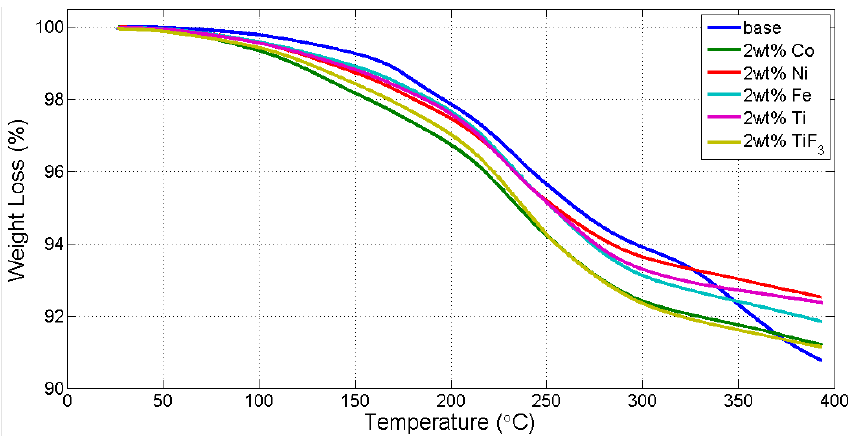
Figure 3. TGA analysis of the different catalysts on LiNH 2 -nanoMgH 2 (2:1).